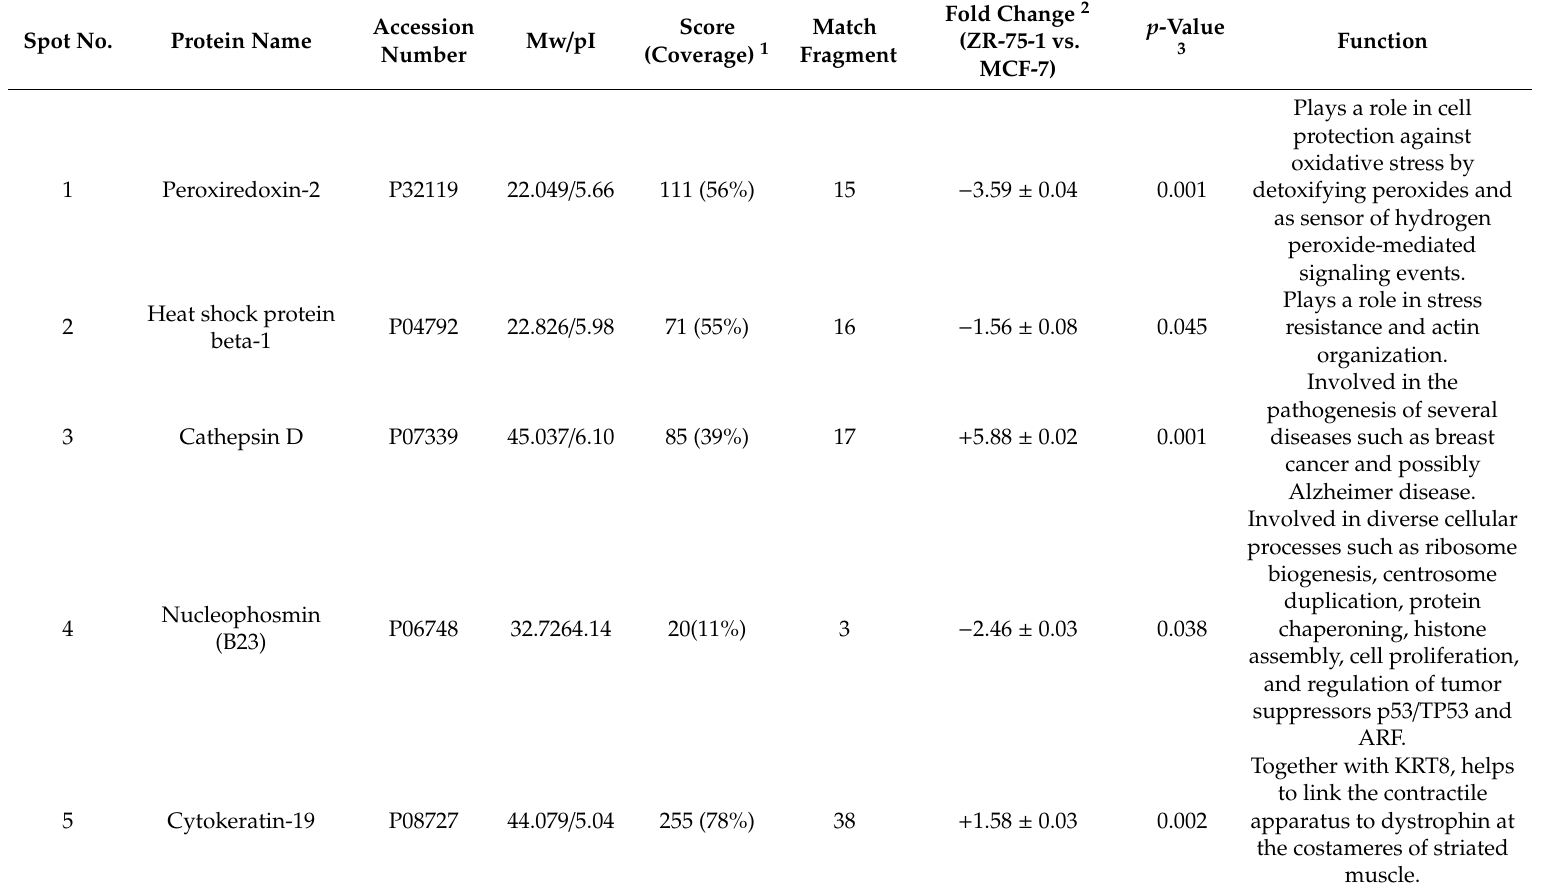
Table 1. List of di ff erentially expressed proteins between ZR-75-1 and MCF-7.